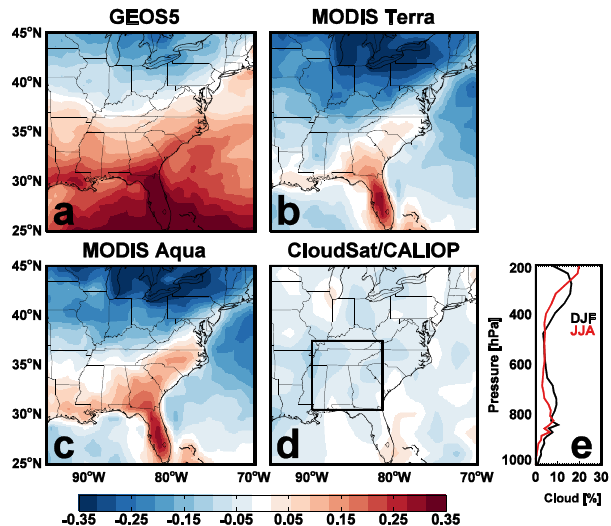
Fig. 7. Differences (summer–winter) between average cloud frac- tion for 2006–2009 (a) from GEOS-5 sampled to afternoon over- pass, (b) observed by MODIS onboard Terra and (c) Aqua, and (d) observed by CloudSat/CALIOP. Black outline shows region for profiles of average cloud fraction over the SEUS for winter (black) and summer (red) observed by CloudSat/CALIOP in 2009 shown in panel (e)